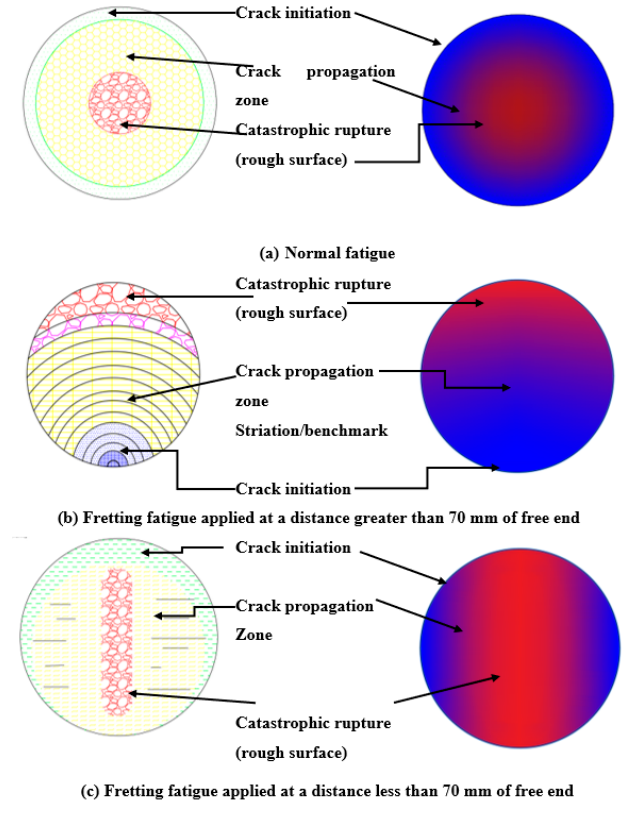
Figure 7. Schematic diagram of fractured PTFE surface. For normal fatigue, no naked eye irregularities are found in the fractured